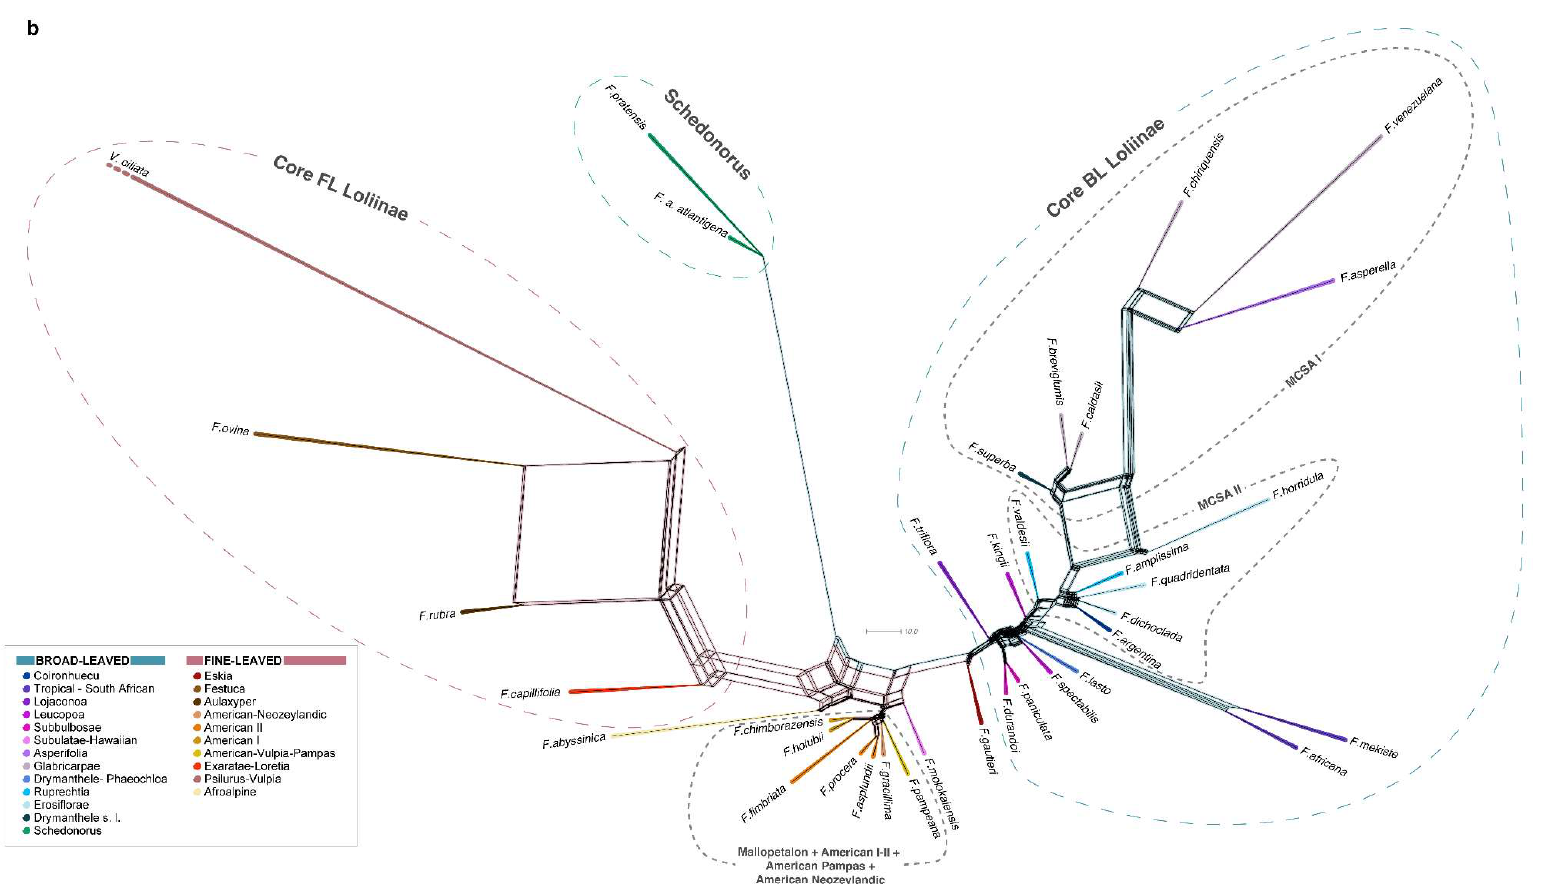
Figure 3. ( a ) Histograms of repeat contents per holoploid genome (1C) retrieved from the individual Repeat Explorer 2 (RE2) analyses of the studied Mesoamerican and South American broad-leaved Festuca taxa and other Loliinae samples. Color codes for repeat types are indicated in the chart. ( b ) Phylogenetic network based on standardized repeat data sets retrieved from the comparative RE analysis and constructed from distance-based NJ trees computed with pairwise Euclidean distances between samples. Core BL, core FL, Schedonorus, Mexico–Central–South American (MCSAI, MCSAII), and Mallopetalon + other American Loliinae groups are surrounded by dashed lines. Color codes of Loliinae lineages are indicated in the